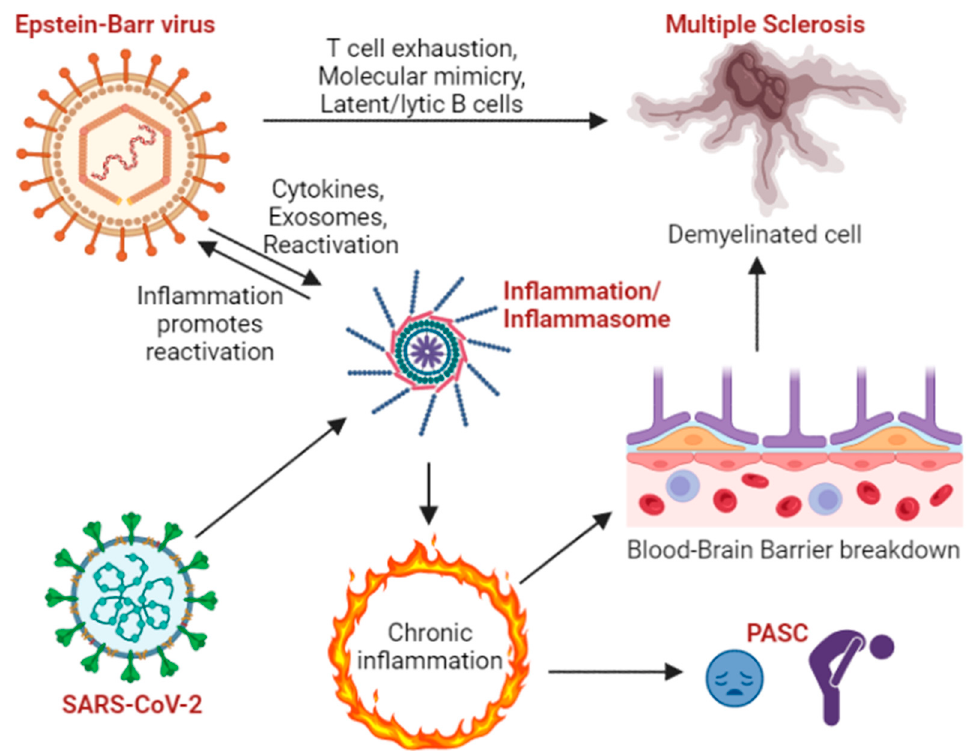
Figure 1. Inflammation at the intersection of EBV, MS, SARS-CoV-2, and PASC. EBV latent and lytic states can cause inflammation, and assembly/activation of the inflammasome can reactivate EBV. Neuronal demyelination contributes to MS, but EBV also contributes to MS through T cell exhaustion and molecular mimicry where latent or lytically infected B lymphocytes instigate immune dysregulation. SARS-CoV-2 activates the inflammasome and elicits inflammatory responses, which may trigger chronic in fl ammation, contributing to PASC. Chronic in fl ammation may also lead to BBB breakdown, which precipitates and/or exacerbates MS. Image created in BioRender.com accessed on 11 April 2023.